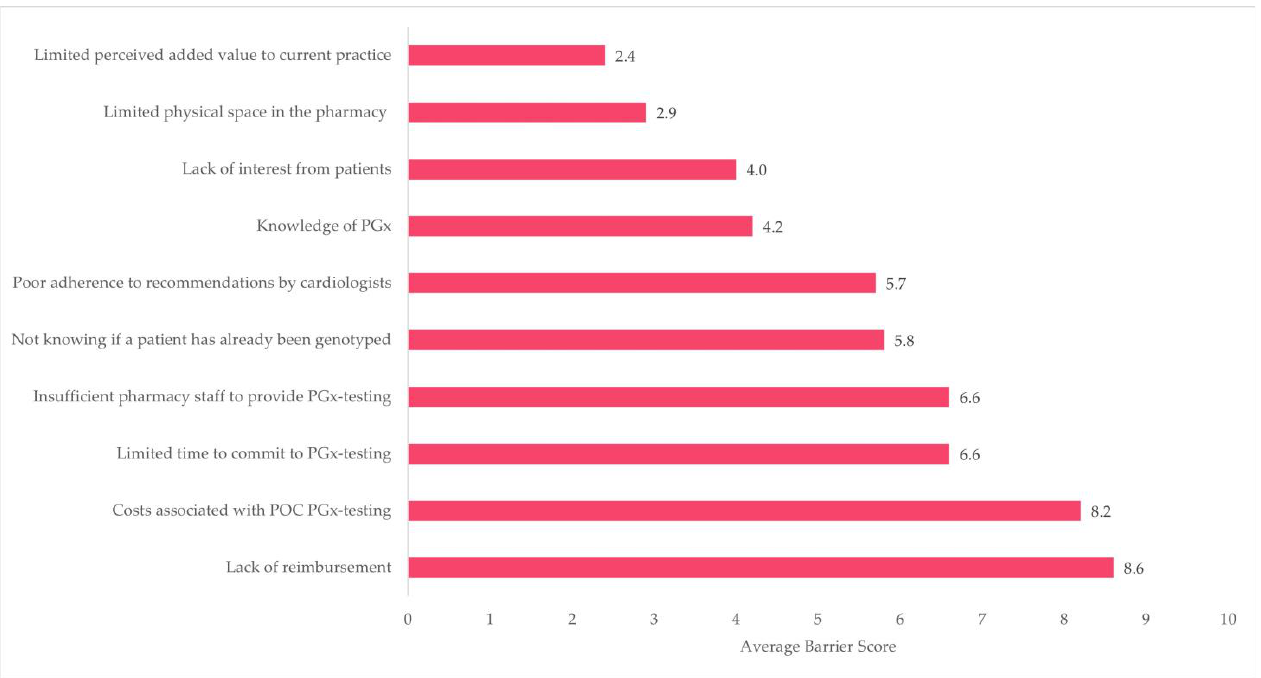
Figure 4. Community pharmacists ’ ranking of ten commonly perceived barriers [32] to the imple- mentation of PGx testing in community pharmacies. The average barrier score is the average score from 0 to 10 given to each barrier by each community pharmacist ( n = 14). The barrier with the highest score is ranked first, while the barrier with the lowest score value is ranked least. Matrix ranking and barrier scores given by each community pharmacists are presented in Supplementary Table S5. PGx, pharmacogenetics; POC, point-of-care.